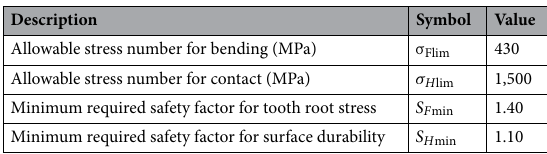
Table 1. Factors for gear rating (for pinion and